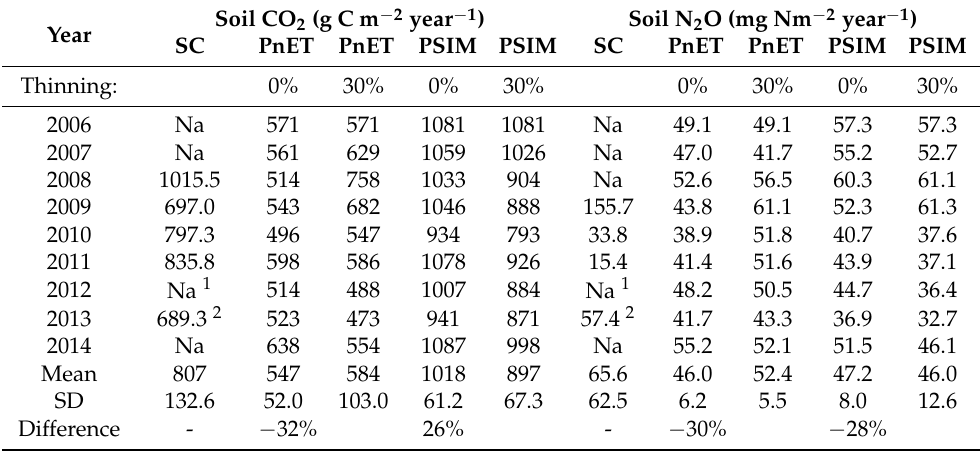
Table 6. Annual soil gas fluxes for 2008–2014 at the Tower Site of the Straits Inclosure comparing measured soil chamber (SC) data with data simulated using PnET and PSIM . Results from a simulated 30% thin in Sept 2007 are also given. Mean values given are averaged over years after thin, 2008–2014.